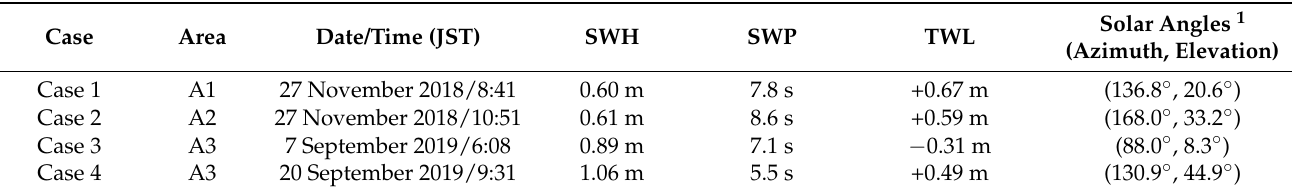
Table 1. Field test conditions: significant wave height (SWL), significant wave period (SWP), tidal water level (TWL), and solar angle.